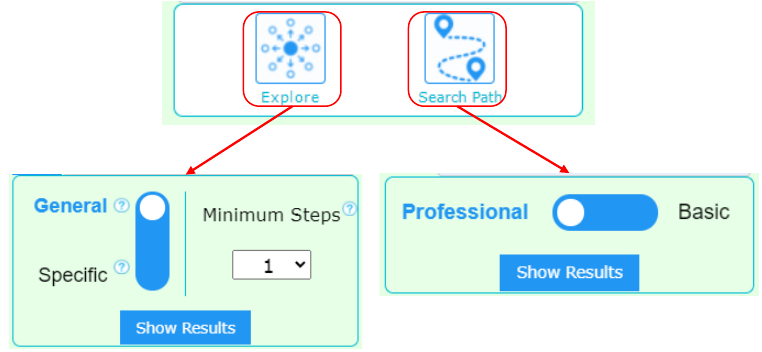
Figure 2. Four functions in the panel of